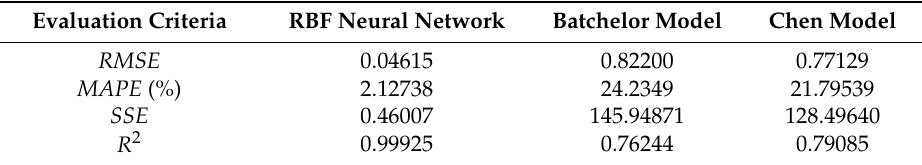
Table 5. Comparisons of the RBF predicted viscosity ratio of TiO 2 -ethylene glycol nanofluids with the experimental data of Chen et al. [12].